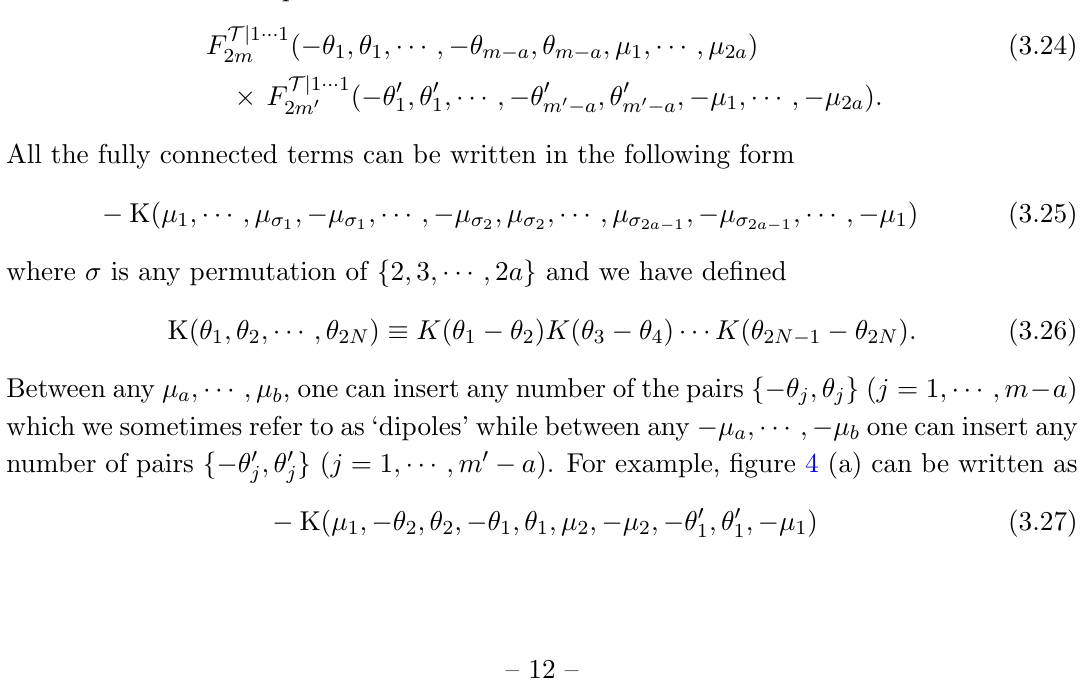
Figure 4 . Diagrammatic representation of terms of F T K ij . When two dashed lines cross, we multiply by an extra ( (cid:0) 1). Diagram (a) corresponds to a fully connected term while diagram (b) corresponds to a term which factorizes into two